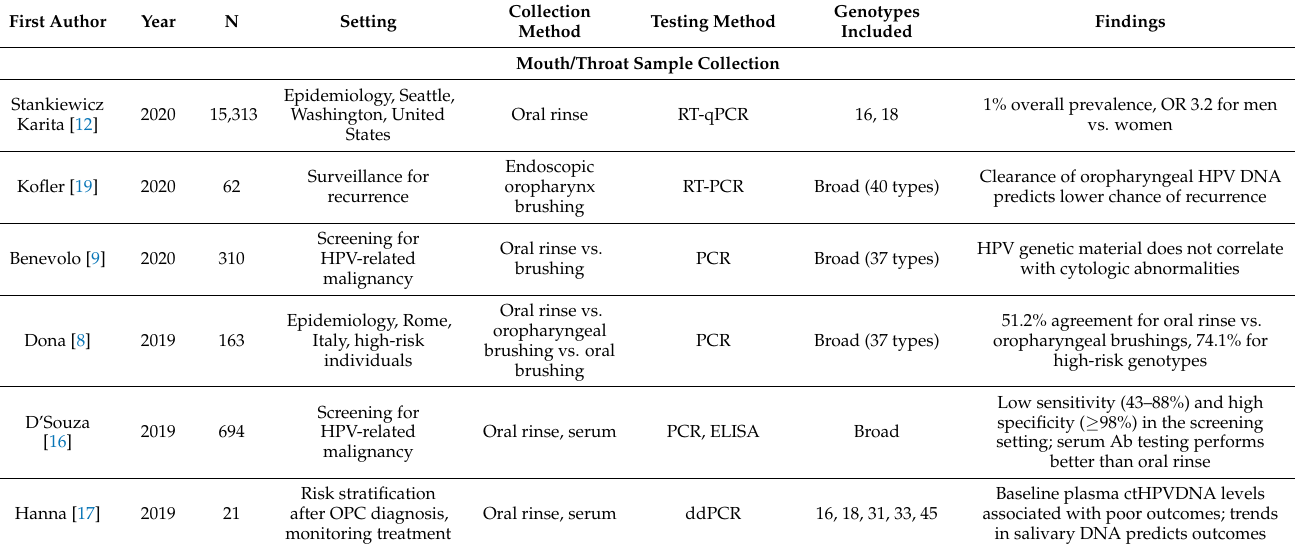
Table 1. Selected recent studies of non-invasive HPV